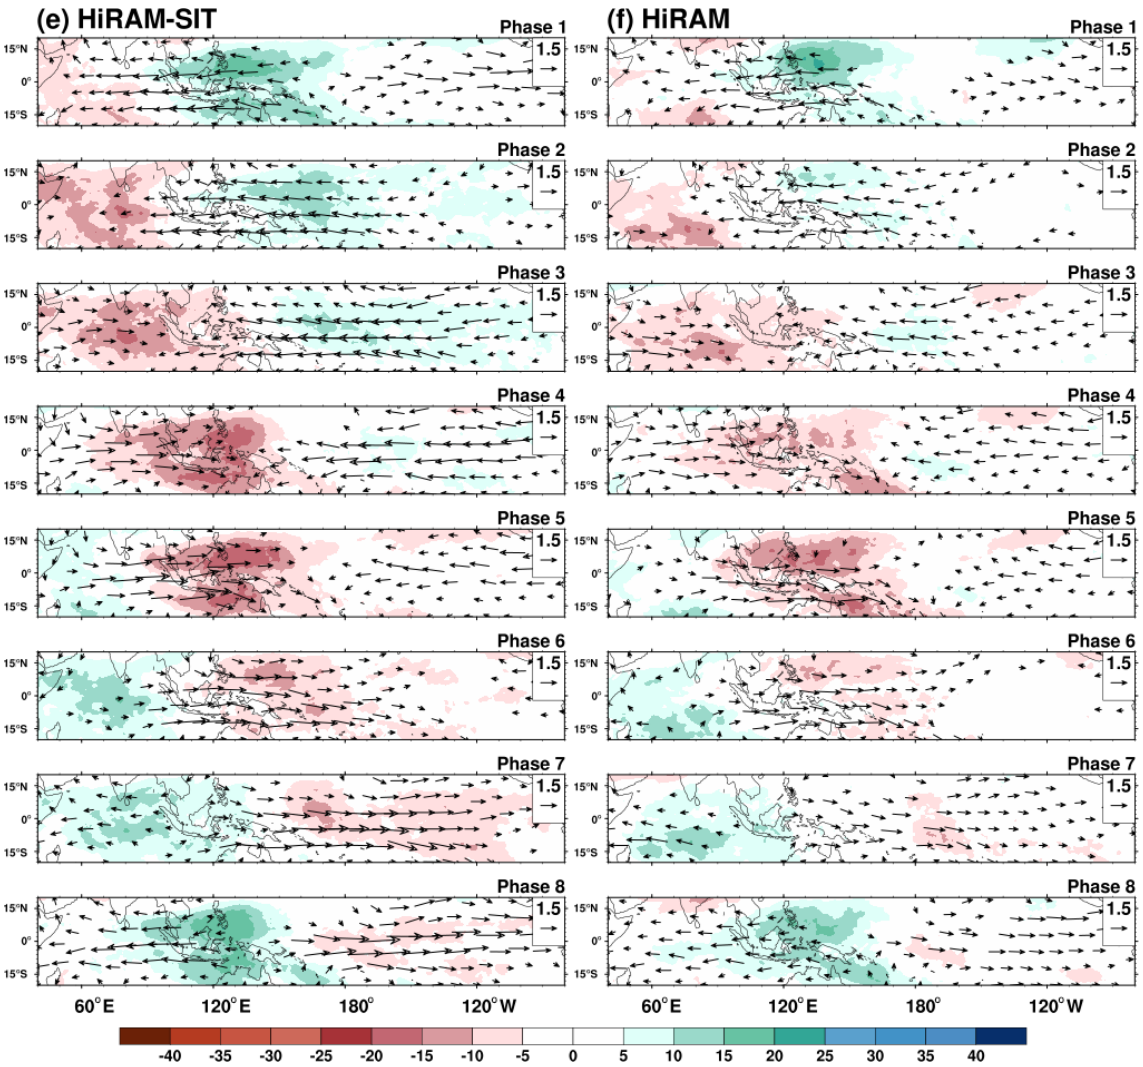
Figure 3. Composite November–April 20–100d OLR (Wm − 1 ; shading) and 10m surface wind anomalies (ms − 1 ; vectors) as a function of the MJO phase in (a) ECHAM5-SIT, (b) ECHAM5, (c) CAM5-SIT, (d) CAM5, (e) HiRAM-SIT, and (f) HiRAM. Vectors < 0 . 6ms − 1 are not shown. The reference vector is shown (in units of ms − 1 ) at the bottom right. The number of days used to generate the composite for each phase is shown to the right of each